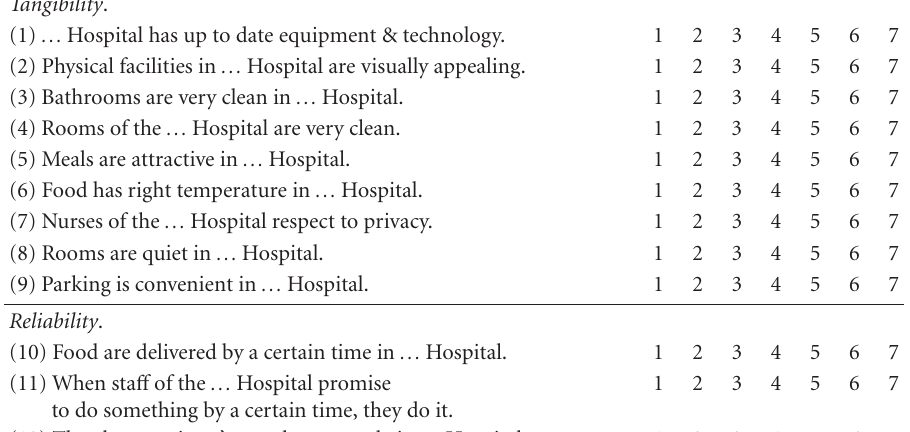
Table B.1. Performance ( P t : an average of the values of the performance factors below). Tangibility